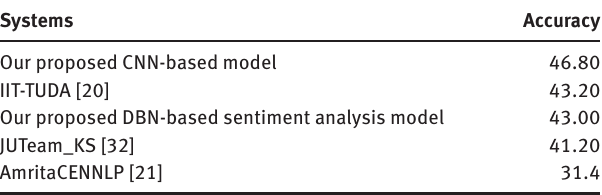
Table 3: Comparisons of Our Proposed Models with Top Three Systems Participated in SAIL 2015 Contest (Constrained Mode).